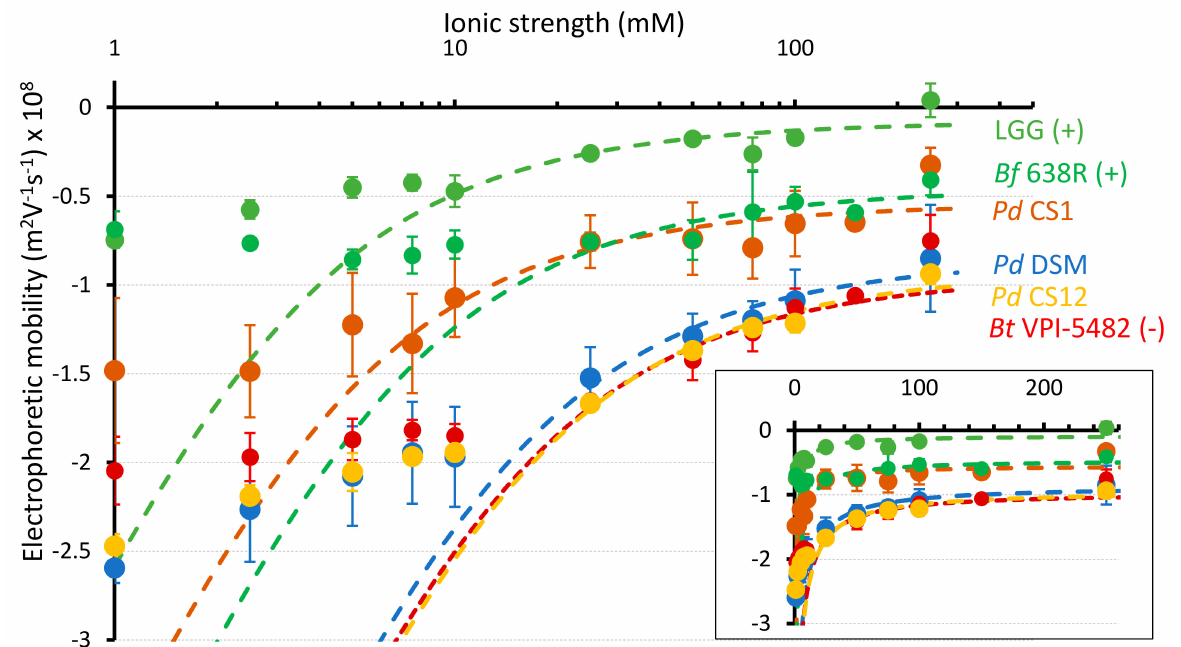
Figure 2. Impact of electrolyte concentration on the electrophoretic mobility of 3 P. distasonis strains (CS1, CS12 and DSM 20701 T ) and controls LGG, Bf 638R and Bt VPI-5482. Points: experimental data. Dotted lines: fitting of the experimental electrokinetic data by the theoretical expressions 2-5 for the electrophoretic mobility of soft particles. In inset, electrokinetic data are represented according to linear axis in electrolyte concentration. Error bars reflect standard error of the mean. Data represent mean ± standard error from at least two independent experiments performed with each strain in triplicate (n = 2 ×